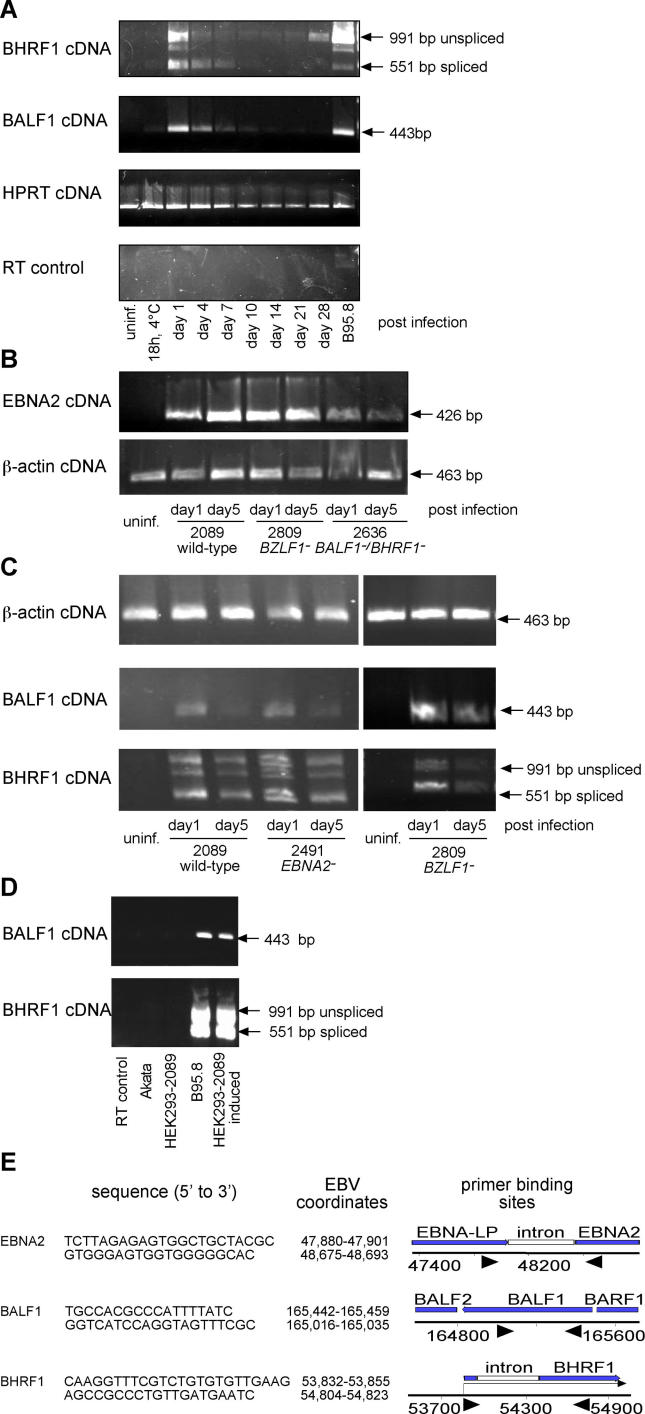
Detection of EBNA2, BALF1, and BHRF1 Transcripts by RT-PCR Analysis(A). Primary B cells were infected with B95.8 EBV, and RNA was prepared at various time points. The expression of BALF1, BHRF1, and HPRT (as control) was analyzed by RT-PCR. (B). Primary B cells were infected with wild-type 2089 EBV, the BZFL1− mutant 2809, or the BALF1−/BHRF1− mutant 2636 (MOI 0.1), and the expression of EBNA2 was determined by RT-PCR. EBNA2 mRNA was detectable in comparable amounts in cells infected with either virus stock on day 1 and on day 5 p.i. (C). Primary B cells were infected with wild-type 2089 EBV, the BZFL1− mutant 2809, or the EBNA2− mutant 2491. Similar to (A), vBcl-2 transcripts were detectable in comparable amounts in cells infected with either virus stock on day 1 and on day 5 p.i. but at a reduced level on day 5. (D). BALF1 and BHRF1 transcript levels in latently infected and lytically induced cell lines. Neither BALF1 nor BHRF1 are detectably expressed in the latently infected, EBV-positive Akata cell line [62] or in 293HEK cells stably transfected with wild-type 2089 EBV. Both mRNAs are easily detectable in B95.8 cells, which spontaneously support productive infection, or in lytically induced 293HEK cells carrying the maxi-EBV 2089). (E) Schematic overview of the PCR primers and their location used to detect EBNA2-, BALF1-, or BHRF1-specific cDNAs. The PCR product indicative of correctly spliced EBNA2 transcripts is 426 bp in length; the BALF1 PCR product is 443 bp in length. BHRF1-specific PCR products are expected to be 551 bp and 991 bp in length, representing the spliced and unspliced transcripts, respectively.